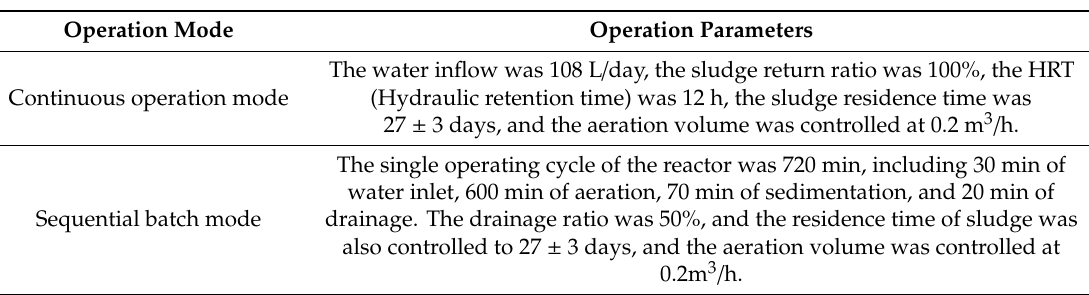
Table 2. Operating parameters of various working